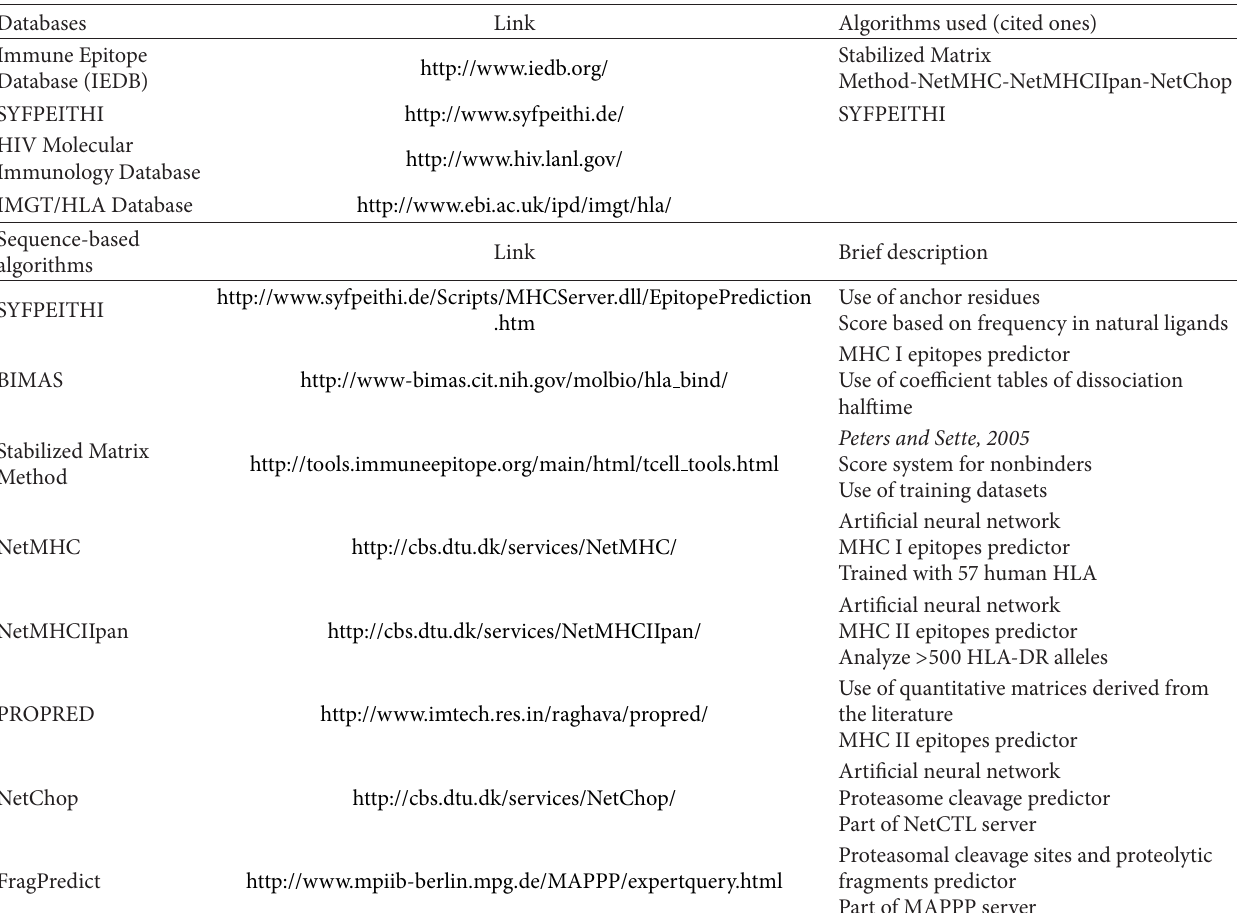
Table 1: Examples of the most commonly used databases and sequence-based algorithms for T-cell epitopes